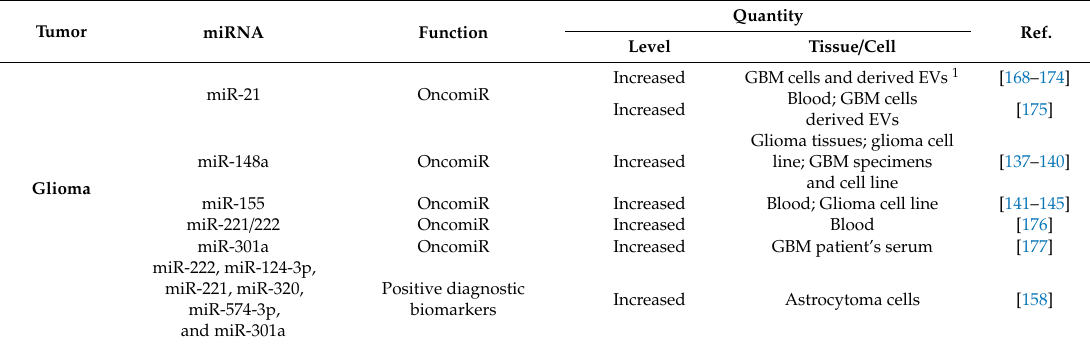
Table 2. MicroRNAs in brain